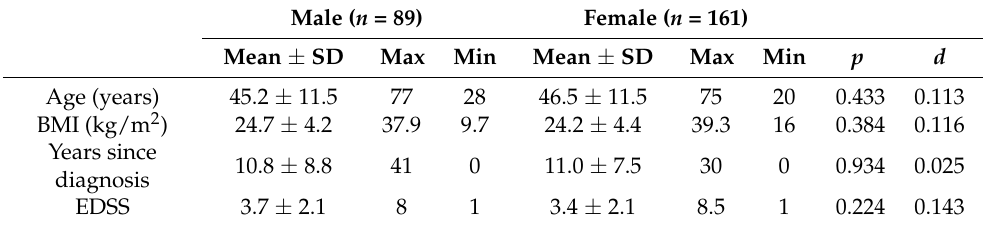
Table 1. Characteristics of the sample population according to gender.